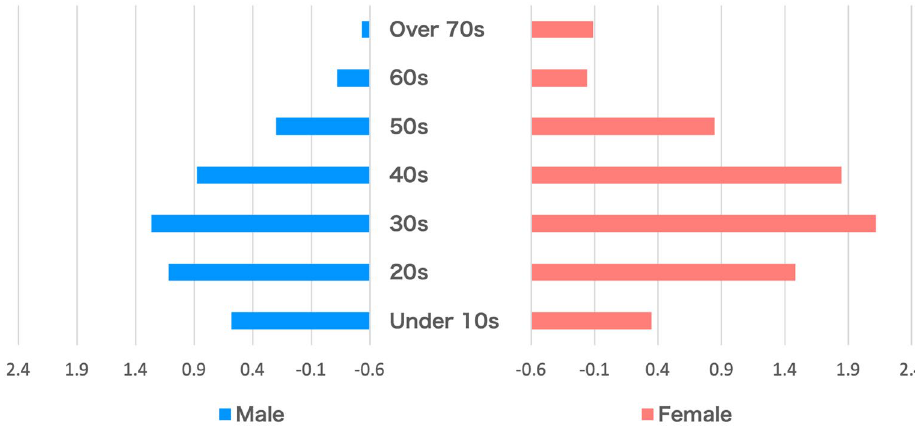
Figure 2. The higher the VCI, the higher the levels of societal concern towards vaccines or